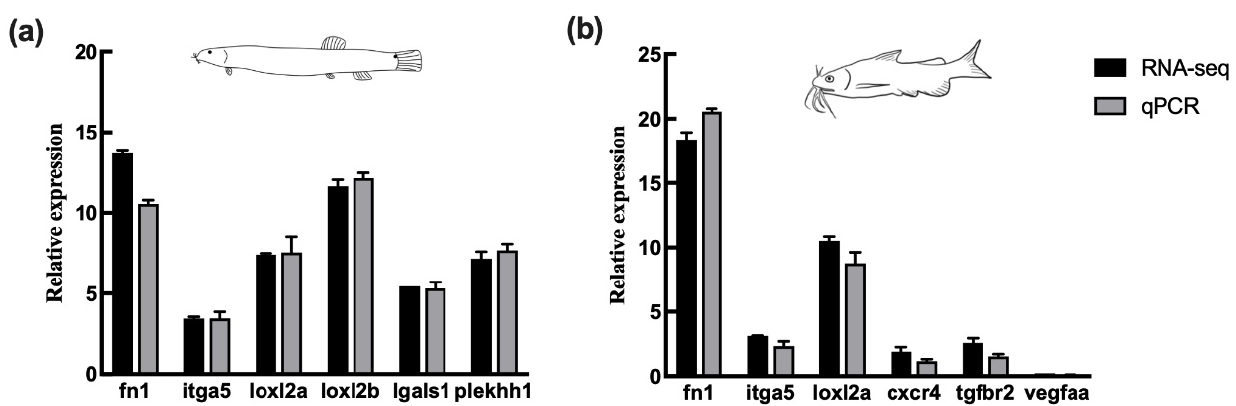
Figure 7. Validation of expression levels of differentially expressed genes (DEGs) in comparisons of RS/OS pertain to loach